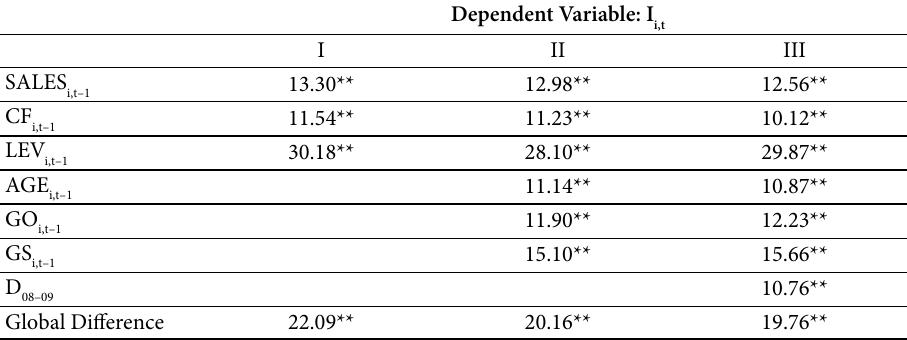
Table 8. Chow test of equality of estimated parameters